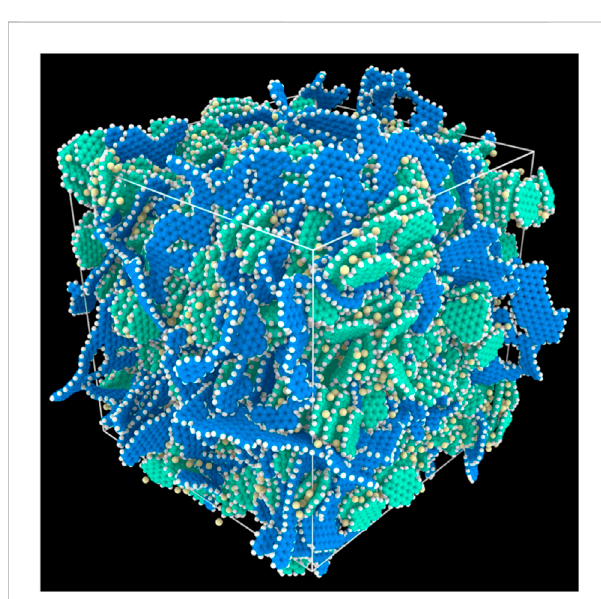
FIGURE 8 The hierarchical carbon anode model after equilibration. Atoms are colored by type: Amorphous carbon is blue, crystalline carbon is green, hydrogen atoms are white, and lithium ions are yellow. This simulation corresponds to a loading of 147.8 mAh g − 1 and an initial condition in which all Li atoms were initially intercalated within the crystalline domain (McNutt et al.,